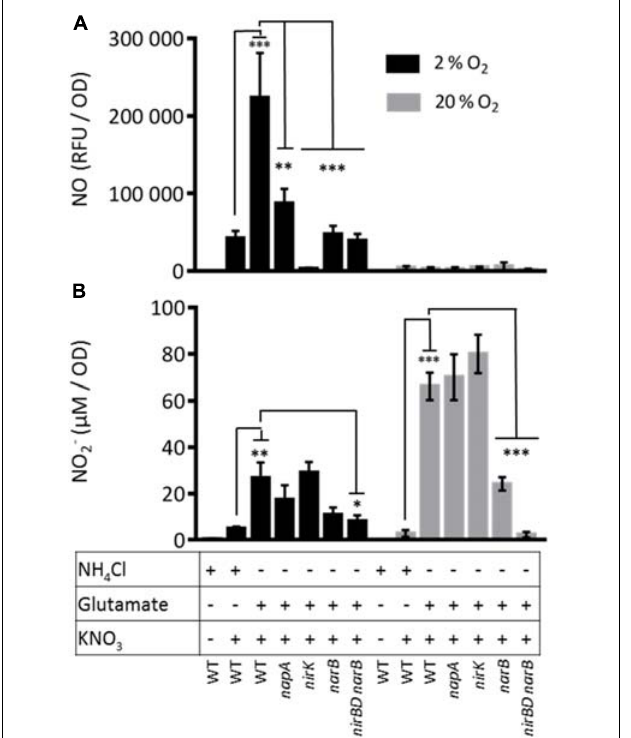
FIGURE 5 | Nitric oxide and nitrite production by S. meliloti WT and mutant strains. S. meliloti strains were grown exponentially at 28 ◦ C in VMM containing either NH 4 Cl or glutamate (OD 600 = 0.2–0.3). To remove NH 4 Cl or glutamate from the medium, cells were collected by centrifugation and resuspended in VMM without NH 4 Cl or glutamate. When needed, KNO 3 (20 mM) was added to the cultures. Cultures were either kept at 28 ◦ C under agitation (aerobic conditions, gray bars) or left without agitation under 2% oxygen atmosphere (microaerobic conditions, dark bars) for 1.5 h. Samples were collected to measure: (A) NO production : NO produced by the bacteria and released in the culture medium was quantified using the fluorescent non-permeable probe DAF-2. Fluorescence was measured using a microplate spectrofluorimeter (excitation wavelength 485 nm/emission wavelength